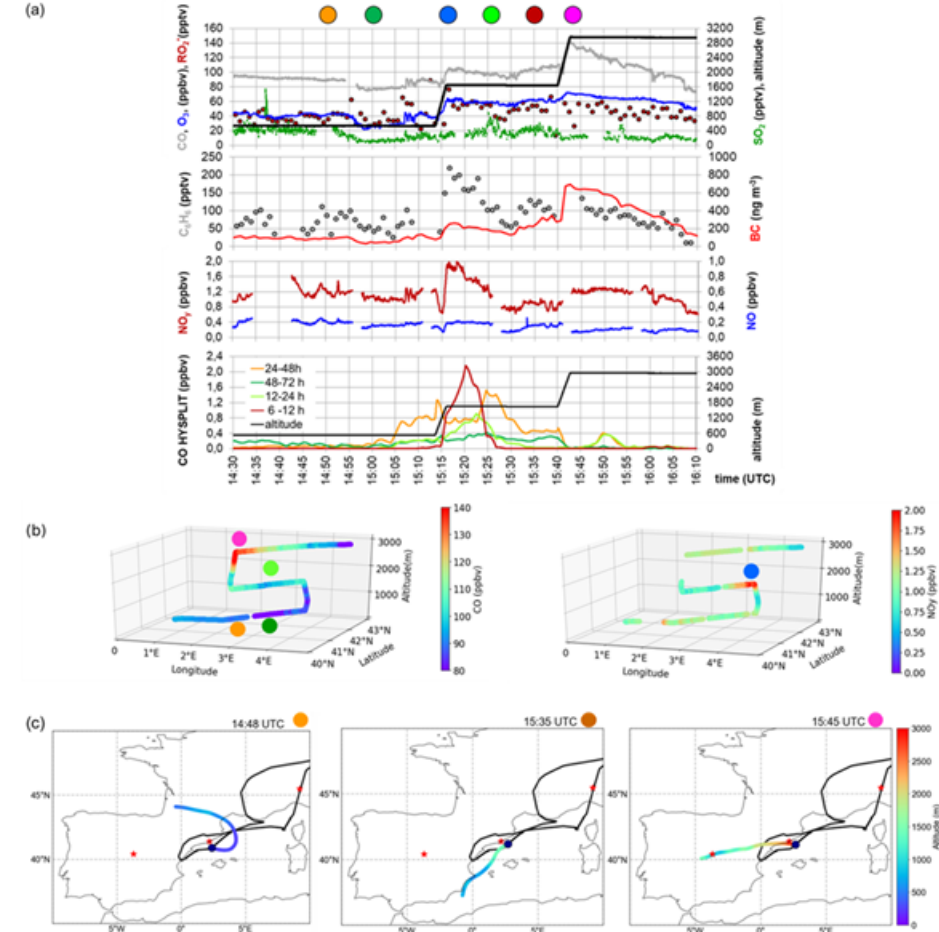
Figure 23. Stratified pollution layers along the Spanish coast during the E-EU-09 flight on the 28 July 2017, (a) temporal variation of CO, O 3 , RO 2 *, NO y , NO, SO 2 , C 6 H 6 , and BC during the shuttle, (b) 3-D view of the shuttle colour coded with CO (left) and NO y (right) mixing ratios, and (c) selected backward trajectories (last 24h). Coloured circles marked the corresponding times in panel (b) . Red stars and the blue dot indicate the position of the MPCs of interest and of HALO,